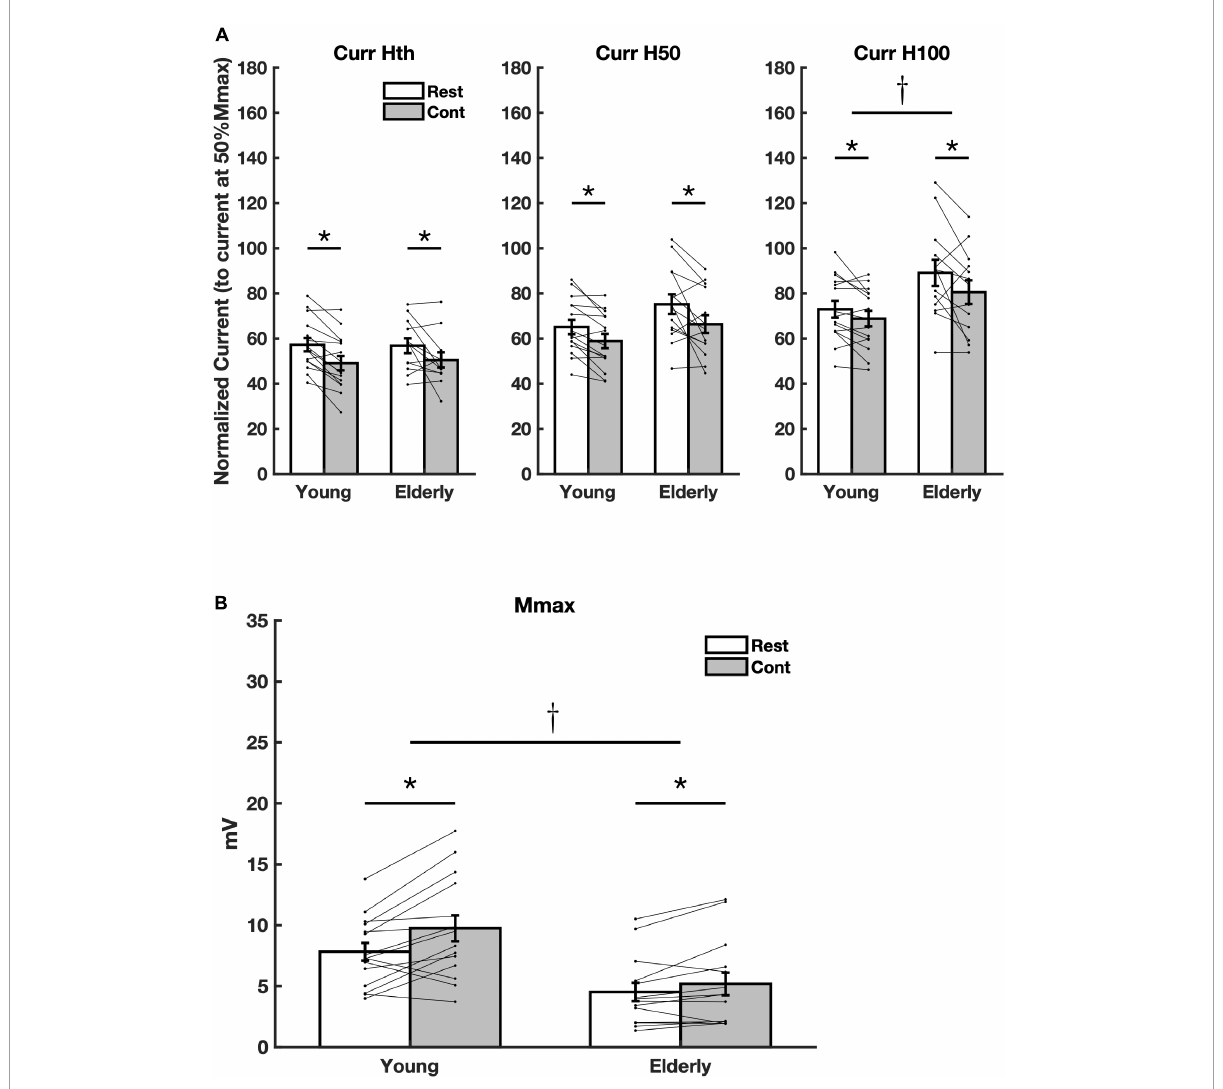
FIGURE2 Averaged current values and Mmax. (A) Current values related to the amplitude parameters Hth (Curr Hth), H50 (Curr H50), and H100 (Curr H100) extracted from the recruitment curve (RC) sigmoid fit. (B) Averaged Mmax amplitude values for all subjects. Asterisks mean significant difference ( p < 0.05) between conditions (Rest and Cont). The dagger means significant difference between group (Young and Elderly) ( p <